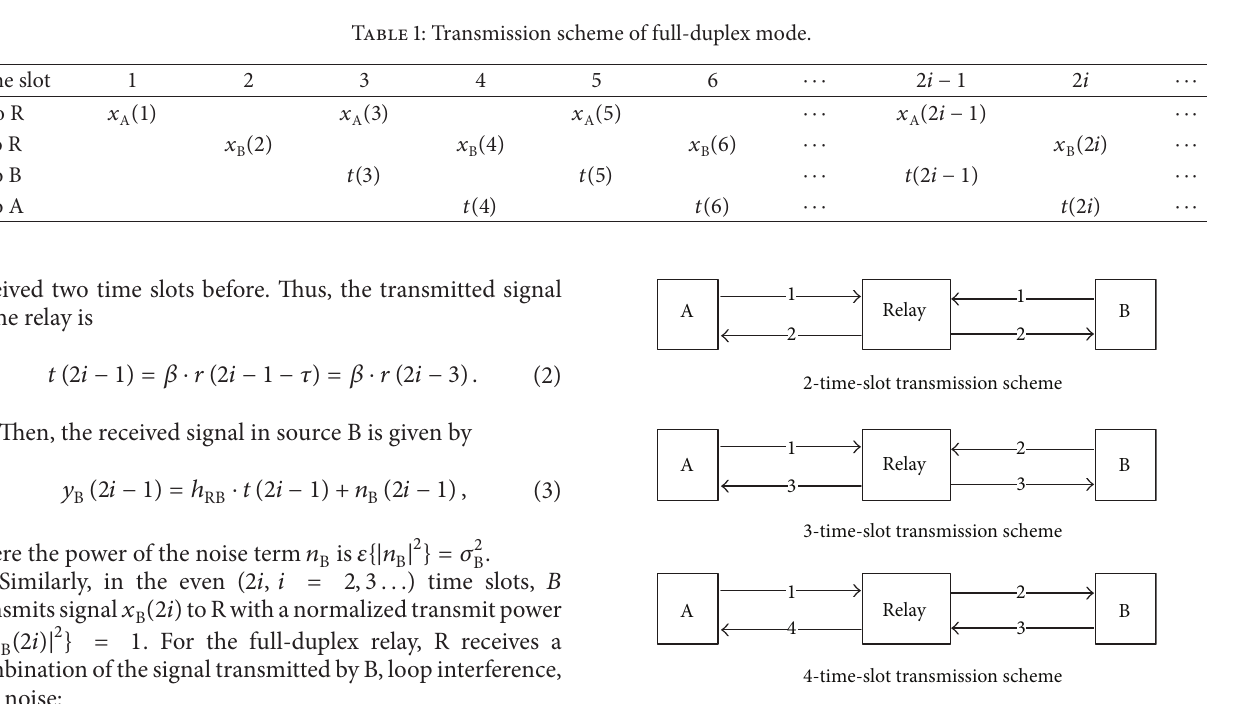
Figure 2: Two-way AF relay channels with different half-duplex